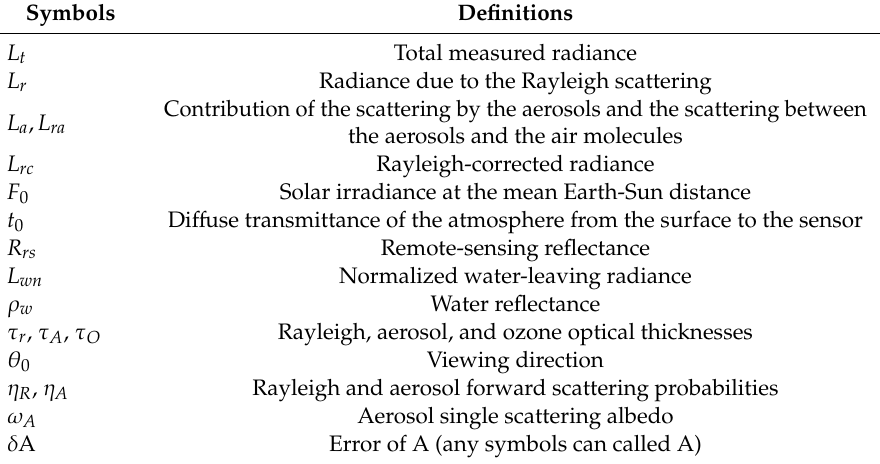
Table 1. Symbols and